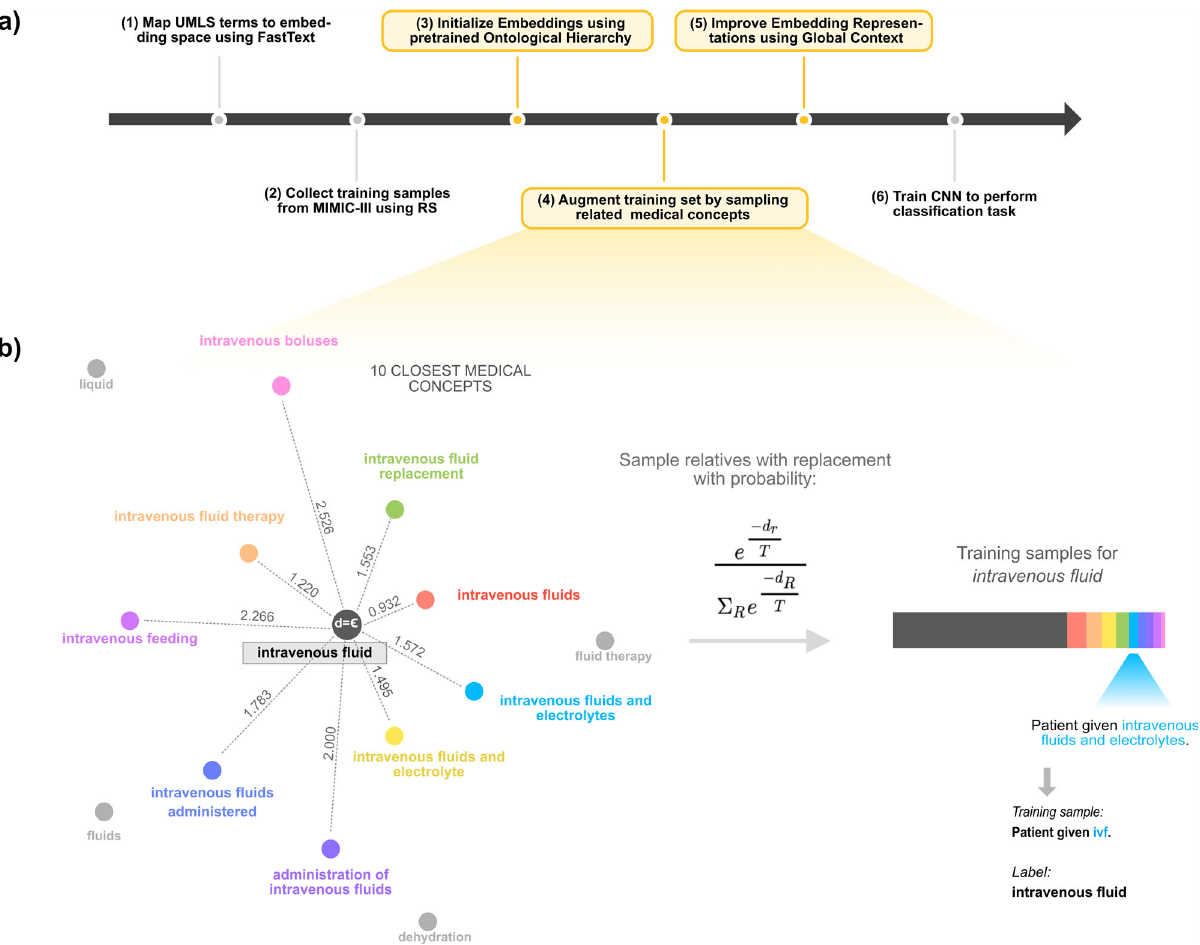
Fig. 1 Overview of our abbreviation disambiguation pipeline for data collection and model training. a Overview of our method. Our key contributions are indicated with yellow boxes. b Illustration of data augmentation technique for the training set. For each expansion, we sample sentences for the ten closest medical concepts using reverse substitution (RS) with a probability proportional to their Euclidean distance in the embedding space. The Euclidean distance is shown above the dotted line connecting the expansion to its relative. The probability of sampling is indicated above the arrow. d r is the Euclidean distance between the expansion and relative and R refers to the ten closest medical concepts. During training, we learn a temperature T using Bayesian optimization that is used in the sampling function. In the event that an expansion is present in the training corpus, we sample it with a distance of ε , which we set to 0.001. We add each sample to our training set by replacing the relative with the abbreviation and using the target expansion as the label. An example of this is shown below the color bar. The color of each relative corresponds to the color in the bar to the right of the arrow, which re fl ects the proportion of the training set composed by that